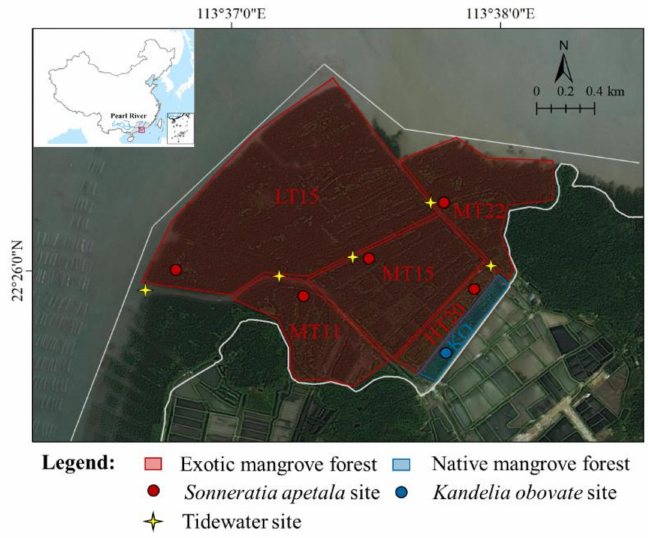
Figure 1. Study area and sampling sites in the Qi’ao mangrove ecosystem, south